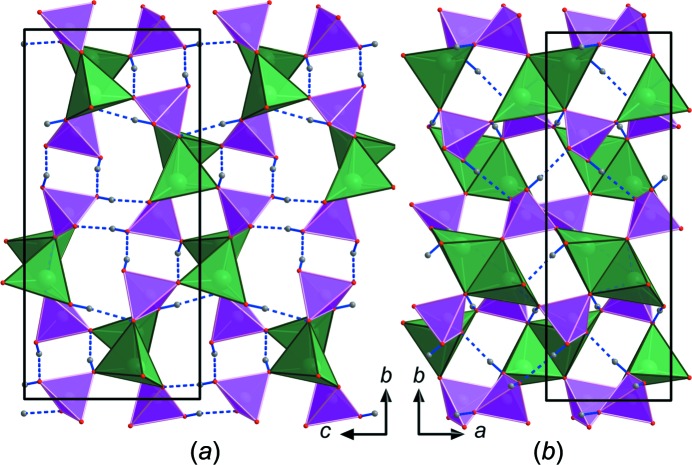
Structural drawings of Li2(H2PO4)2, viewed along (a) a and (b) c. The unit cell is outlined. Phosphate tetra­hedra are shown in pink and edge-sharing LiO4 tetra­hedra in green. The hydrogen bonds reinforcing the network are shown in blue.